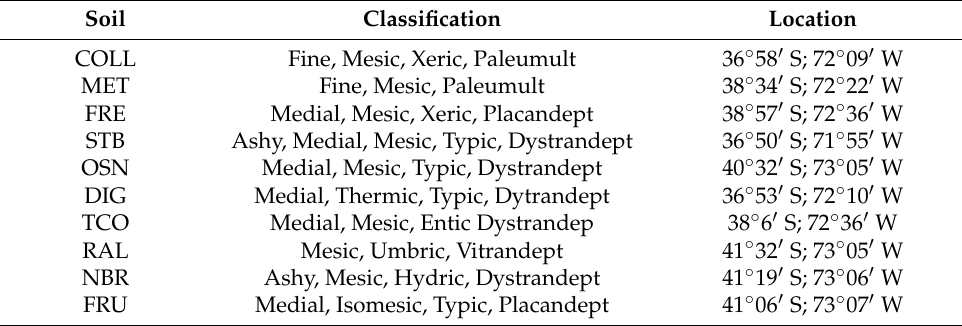
Table 1. Classification and location of volcanic ash-derived soils used in this